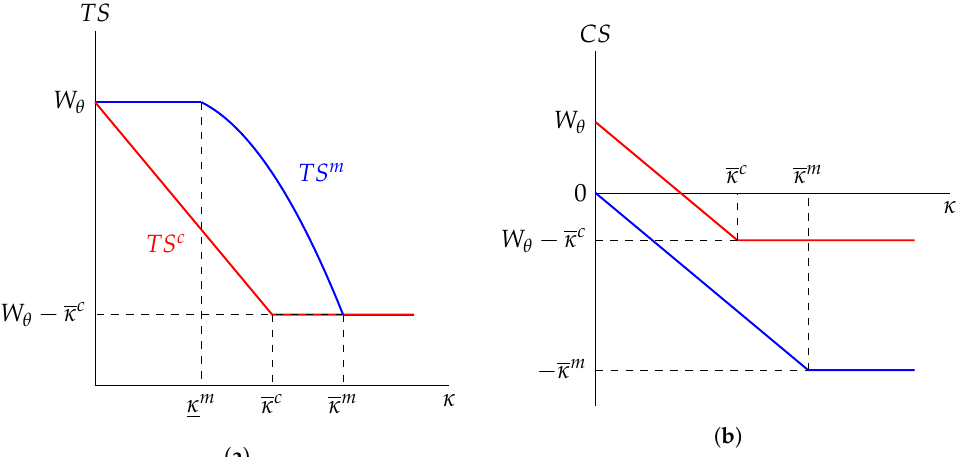
Figure 2. Graphical comparison of cognitive equilibrium outcomes under monopoly and competition. Panel ( a ) compares total surplus as a function of cognitive cost κ , while panel ( b ) compares consumer surplus as a function of cognitive cost κ